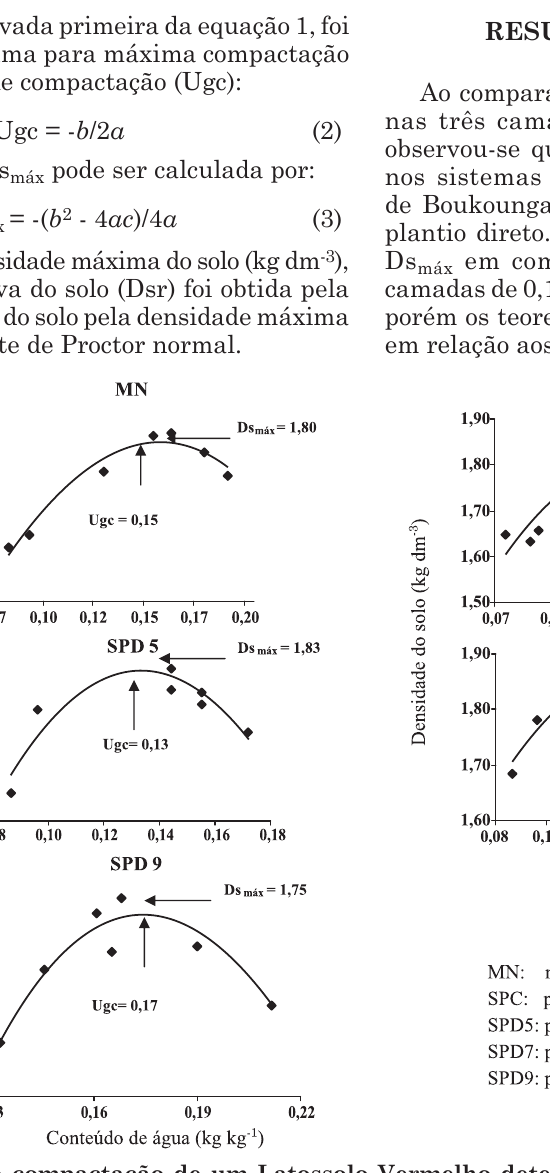
Figura 2. curvas de compactação de um Latossolo vermelho determinada pelo ensaio de proctor na camada de 0–0,10